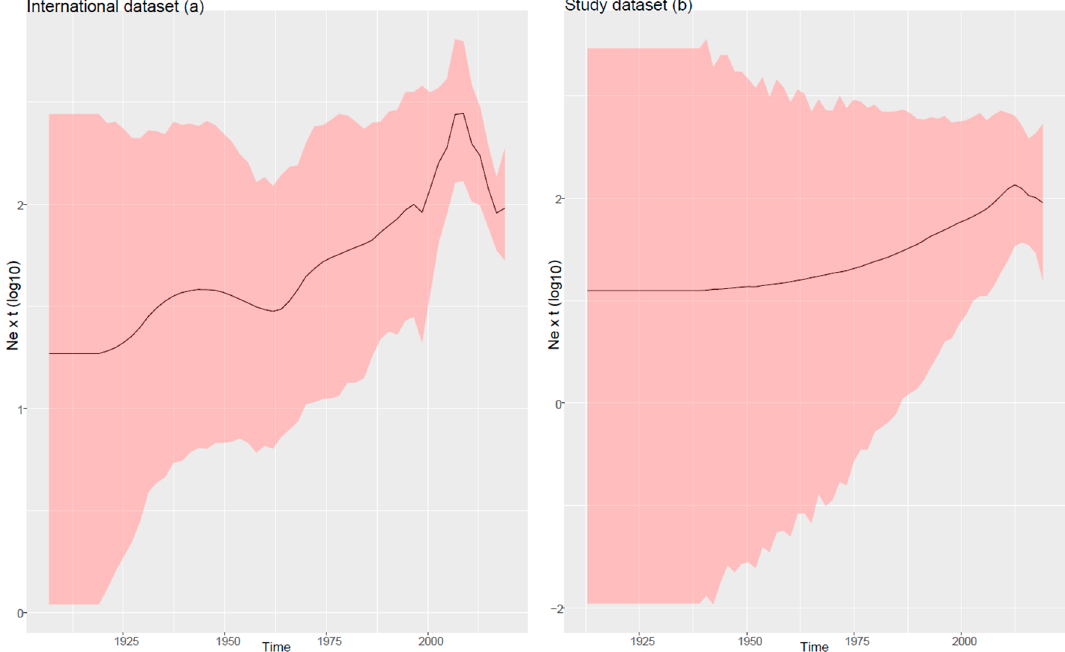
Figure 1. Mean relative genetic diversity (Ne x t) of FPV populations estimated on International ( a ) and Study ( b ) datasets over time. Mean, upper and lower 95HPD values are displayed.